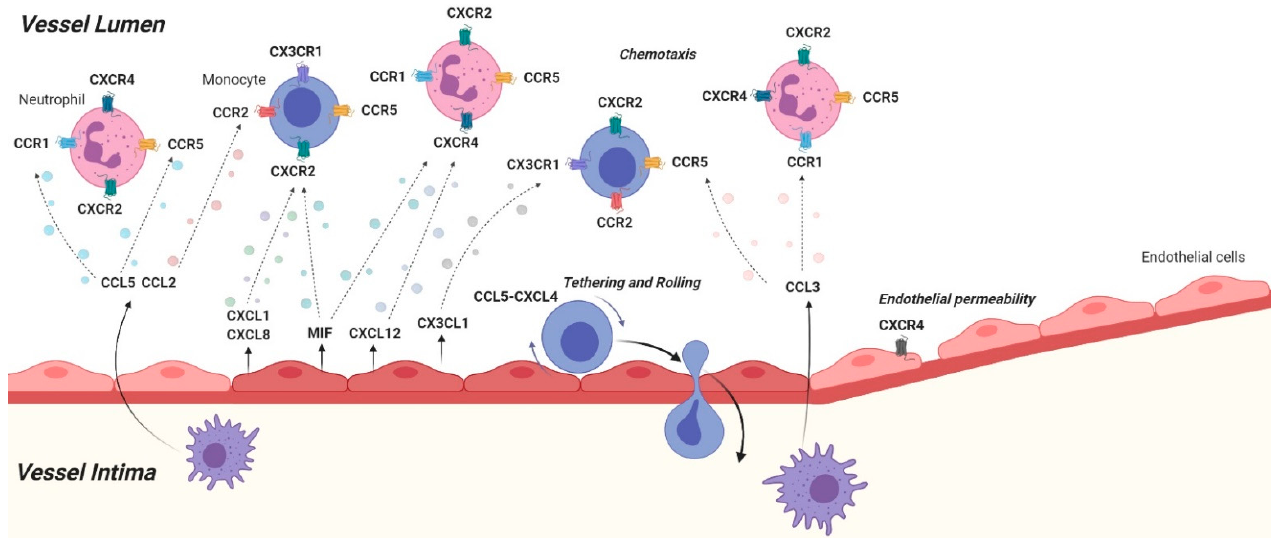
Figure 1. Schematic and simplified overview of the effects that chemokine-chemokine receptor axis have on leukocyte recruitment. Various chemokines and chemokine receptors are visualized that play a role in leukocyte recruitment. Activated endothelial cells secrete a wide variety of chemokines that attract leukocytes like monocytes and neutrophils towards the vessel wall in a process called chemotaxis, followed by tethering, rolling and transmigration. Furthermore, activated macrophages secrete chemokines that stimulate this leukocyte recruitment process and it has been shown that chemokine receptors influence endothelial permeability, which is an important aspect for leukocyte transmigration (Created with Biorender.com).